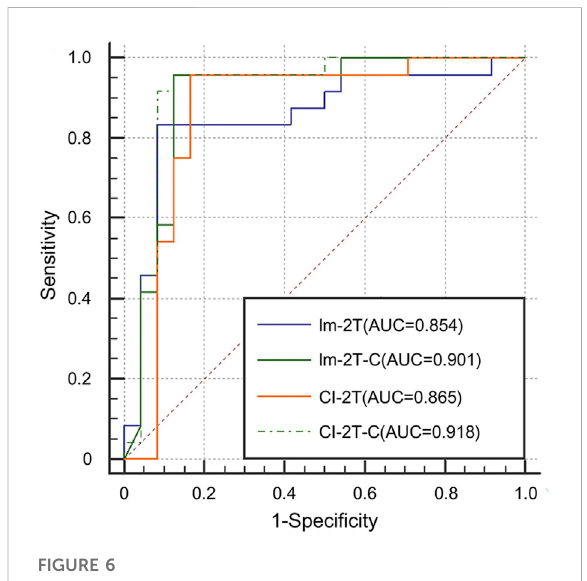
FIGURE 6 ROC curves for the Im-2T, Im-2T-C, CI-2T, and CI-2T-C networks to show the effectiveness of contrastive